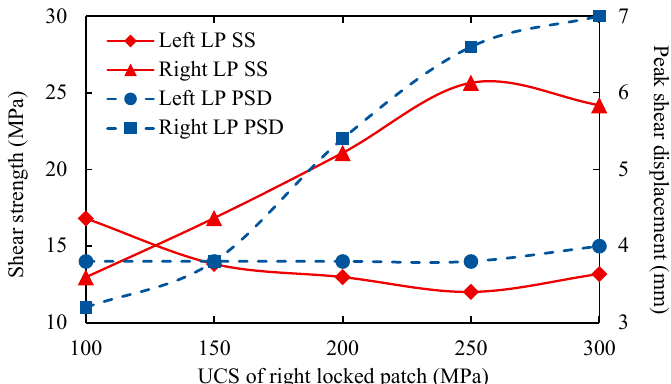
Figure 5. Relationships between uniaxial compressive strength of right locked patch and shear strength and peak shear displacement of two locked patches. LP denotes locked patch, and SS and PSD represent shear strength and peak shear displacement, respectively.